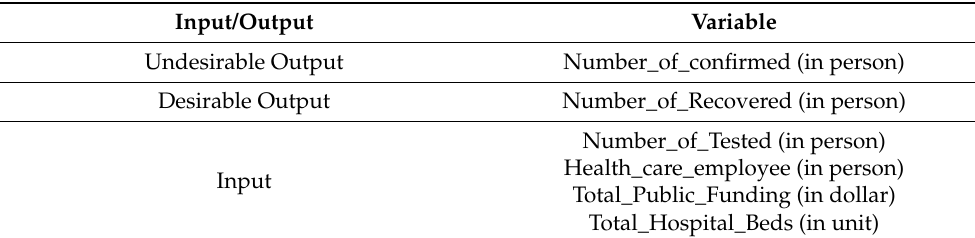
Table 1. Input and output variables used in DEA